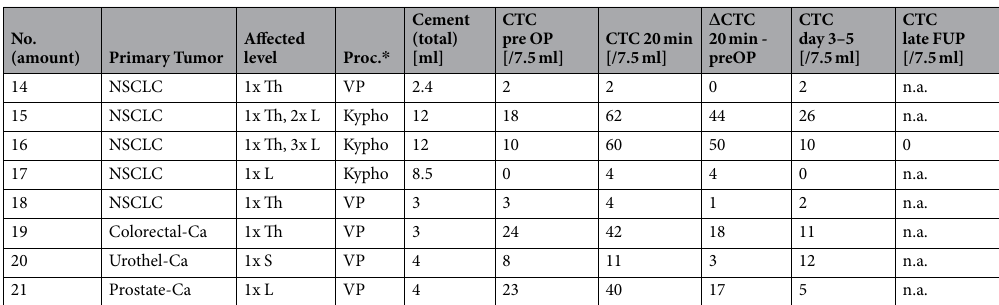
Table 2. CTCs in Patients with Carcinoma Metastases. * VP = Vertebroplasty; Kypho = Kyphoplasty. Circulating tumour cell (CTC) counts of non-breast-cancer group according to procedure and level. L: lumbar, Th: thoracic, S: